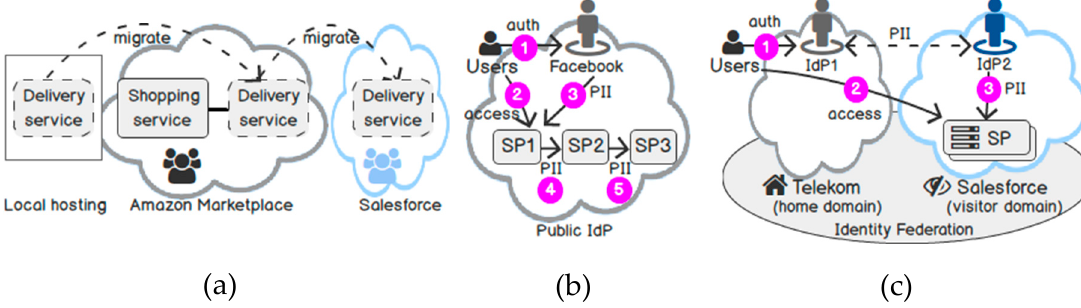
Figure 1. Motivation scenarios. ( a ) Cloud migration; ( b ) Identity propagation; ( c ) Identity federation.